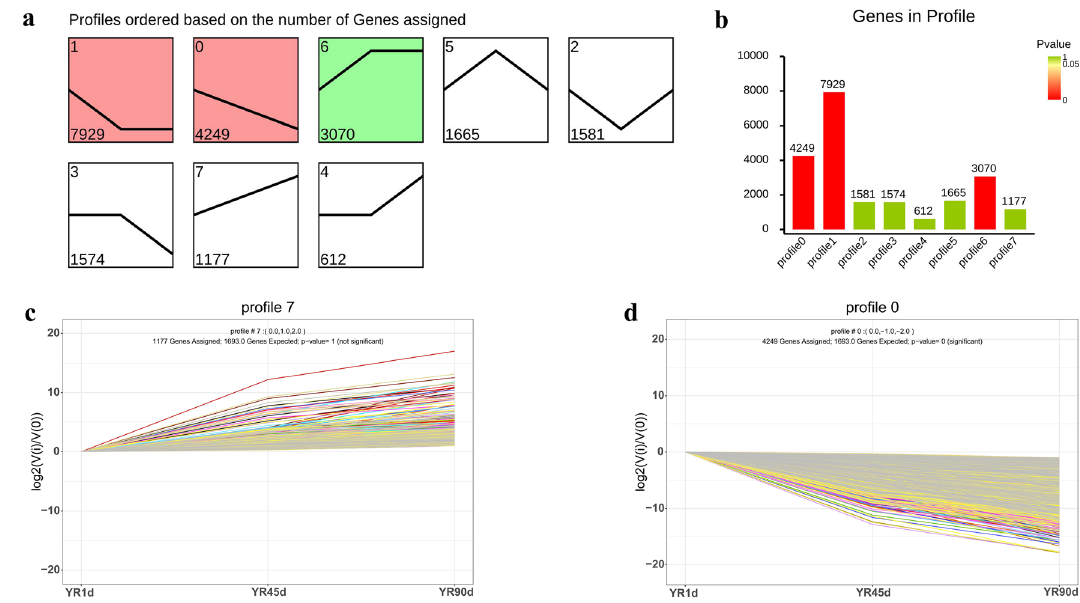
Figure 4. Trend analysis for DEGs. ( a ) Profiles of 8 differently expressed mRNAs. ( b ) Numbers of DEGs in each profile. ( c ) Details of profile 7 in which the expression of genes were continuously upregulated from 1 to 90 dph. ( d ) Details of profile 0 in which the expression of genes were continuously downregulated from 1 to 90